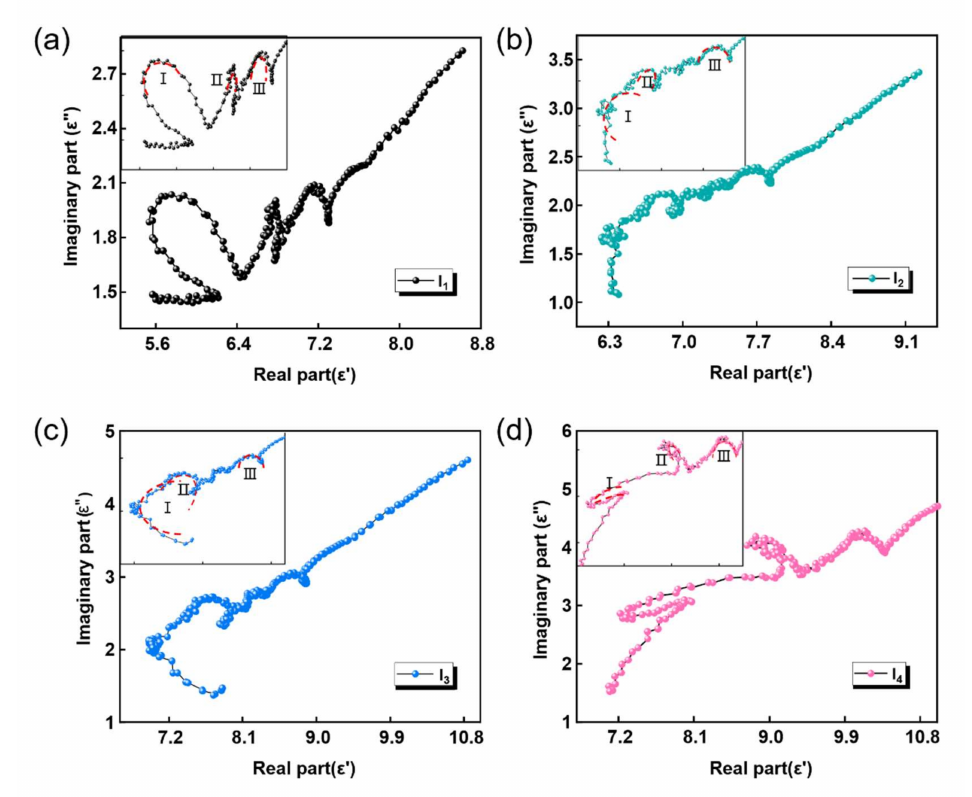
Figure 5. Plots of ε (cid:48) versus ε (cid:48)(cid:48) for ( a ) I 1 , ( b ) I 2 , ( c ) I 3 , and ( d ) I 4